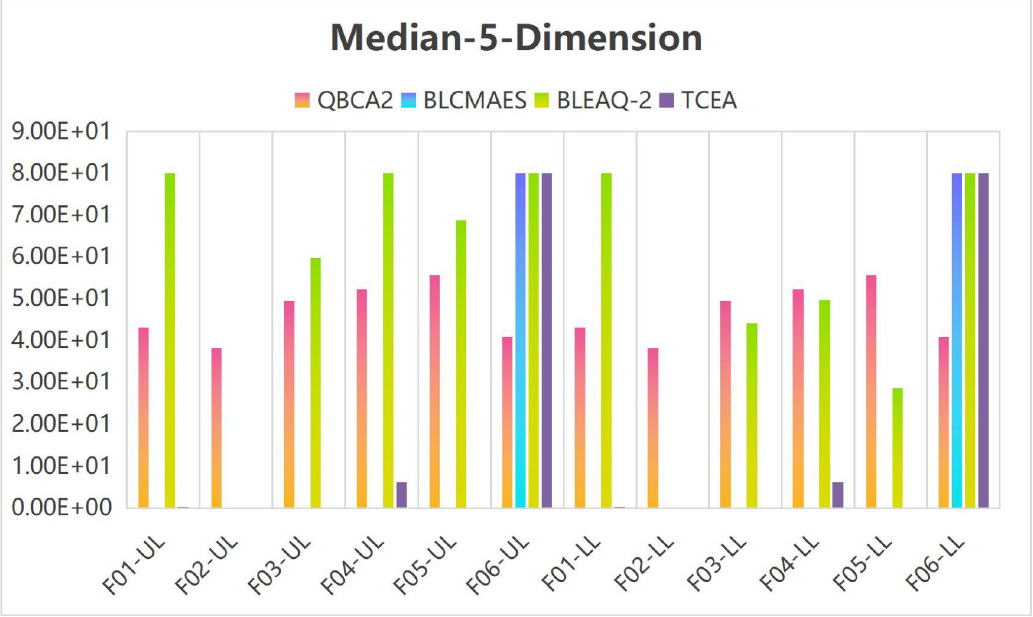
Fig 2. Histogram of the median values on 5-dimensional problems.